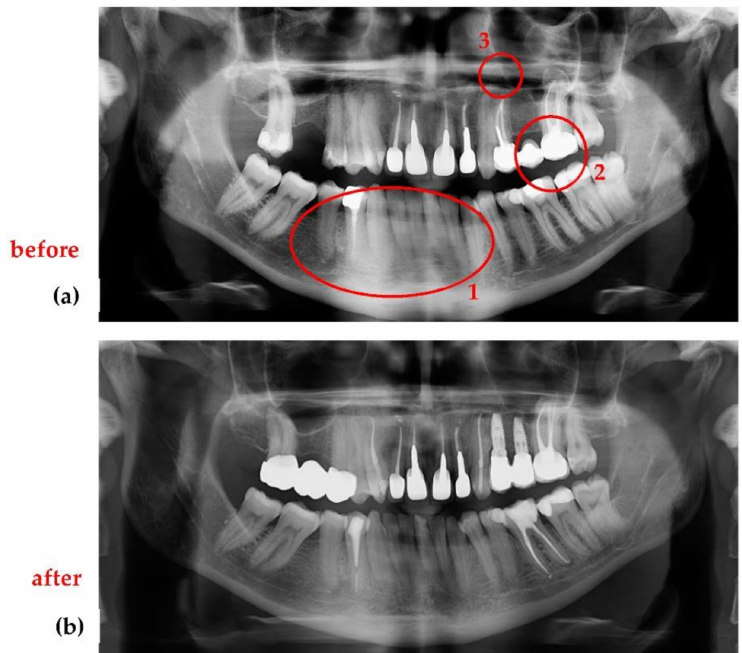
Figure 10. Panoramic radiographs performed on the same patient (L.C., female, 42 years old) ( a ) before and ( b ) after the